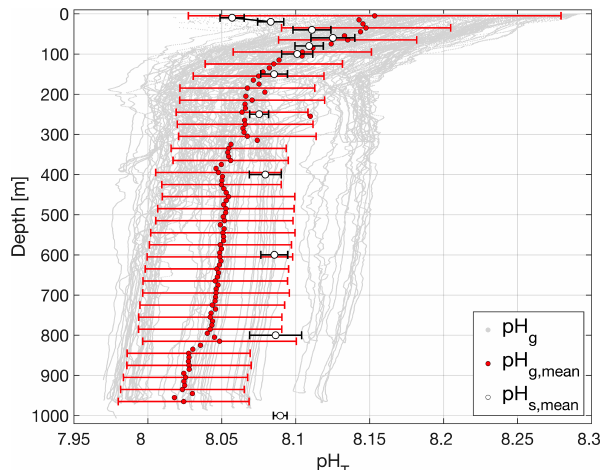
Figure 7. The pH obtained by the glider ISFET sensor (pH g ; grey) is compared with the depth-binned mean of these profiles (red) along with the corresponding standard deviation error bars (using 10m bins) displayed in this figure every 30m. The mean pH values obtained by the ship (pH s ) during the eight CTD casts displayed in Fig. 1 are shown (white), with their relevant standard deviations dis- played as error bars. The mean pH g values and their corresponding standard deviations were calculated using 10m depth bins, whereas the mean pH s values and standard deviations were calculated at each sampled